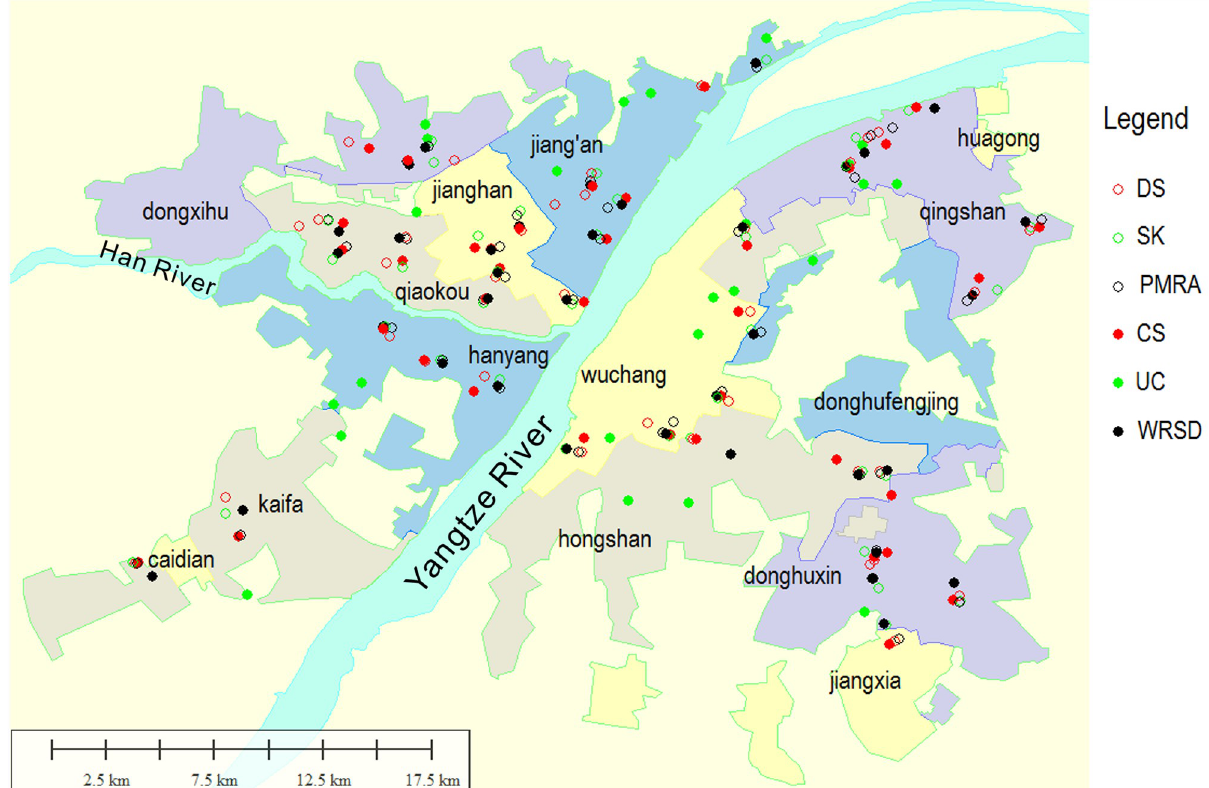
Fig 1. Locations of the study sites for larval surveys in built-up areas of